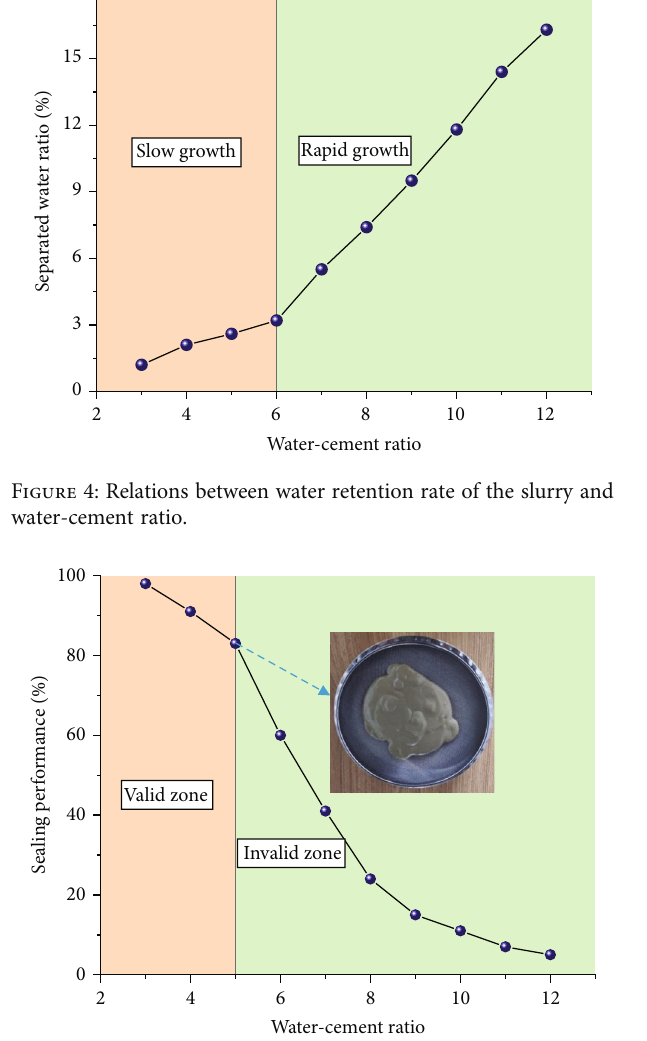
Figure 5: Relations between the slurry sealing performance and water-cement ratio.